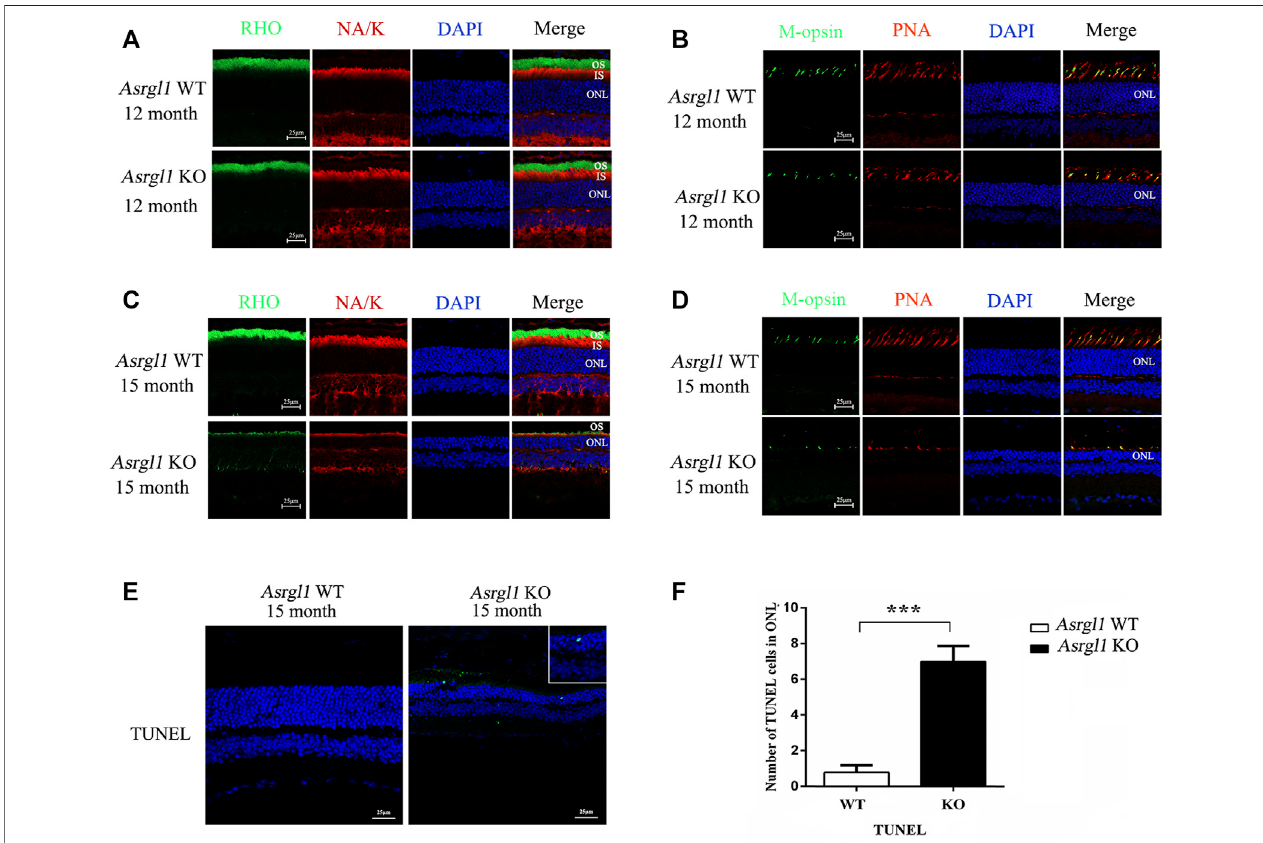
FIGURE 4 | Immuno fl uorescence staining analysis of the Asrgl1 KO retinas. (A,C) Retinal cryosections from 12- and 15-month-old mice ( n (cid:1) 6) were labelled with rod-speci fi cmarkersrhodopsin(outersegment)andNa-KATPase(innersegment). (B,D) M-opsinandpeanutagglutinin(PNA)wasusedastheconemarkersin12-and 15-month-old mice ( n (cid:1) 6). DAPI was used to counterstain the nuclei; scale bars: 25 μ m. The data shown are representative of three independent tests. At least three slides of each retina were stained. (E) TUNEL assays in 15-month-old WT and KO mice revealed increased apoptosis. The magni fi ed square indicated TUNEL- positive cells in the retinas. This experiment was performed three times. Sample size n (cid:1) 6. (F) Quanti fi cation of TUNEL-positive cells in WT and KO retinas; sample size n (cid:1) 6; ppp p < 0.001. Statistical signi fi cance was determined by a two-tailed unpaired t -test.